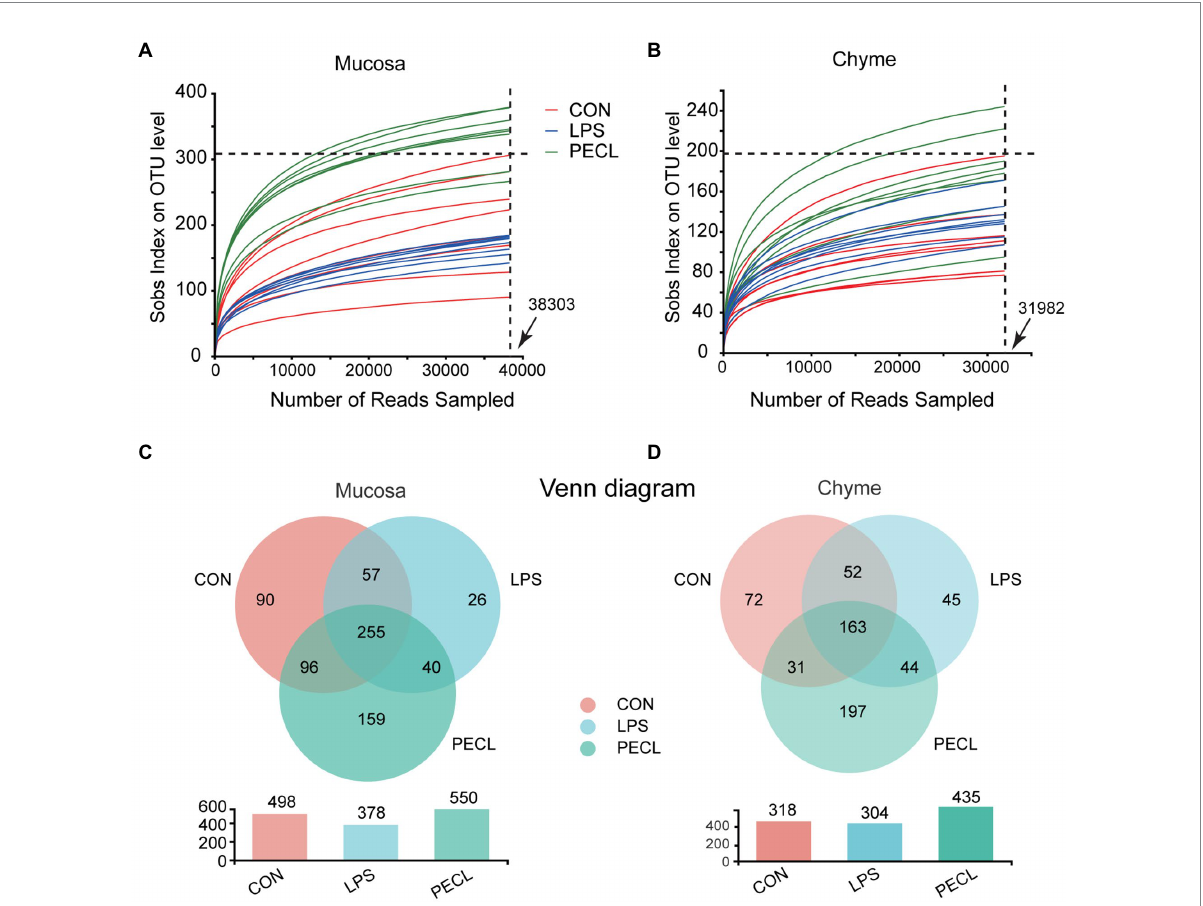
FIGURE 3 Effects of Pectin on Gut Microbiota diversity. (A,B) The rarefaction curves of sobs index on OUT levels of mucosa and chyme in piglets. (C,D) Venn diagrams showing the overlap of the OTUs identified in intestinal chyme microbiota and mucosa. Signification is presented as * p < 0.05, ** p < 0.01, and *** p < 0.001; data are presented as the mean ± SE ( n =